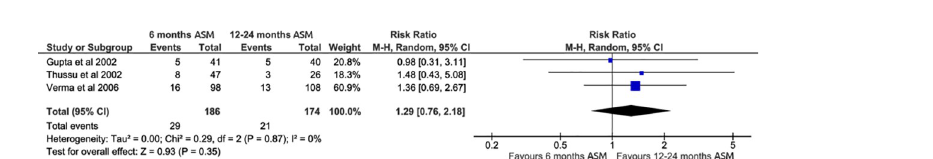
Fig 2. Risk of bias summary—Anti-epileptic drugs. Judgement of the two independent reviewers about each risk of bias item for the included studies.